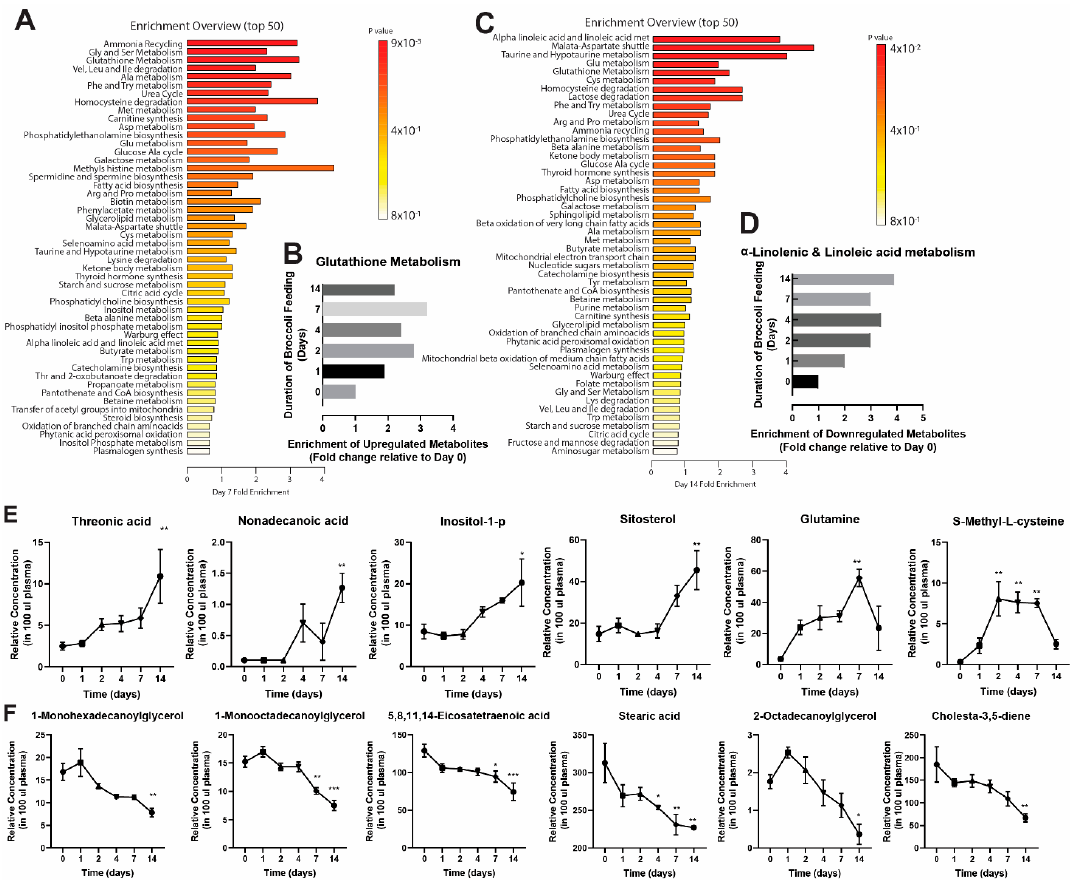
Figure 2. Pathway analysis of metabolite enrichment of up- ( A , B ) and down-regulated ( C , D ) metabolites. Relative concentration of up- ( E ) and down-regulated ( F ) metabolites that change significantly over 14 days of broccoli feeding.